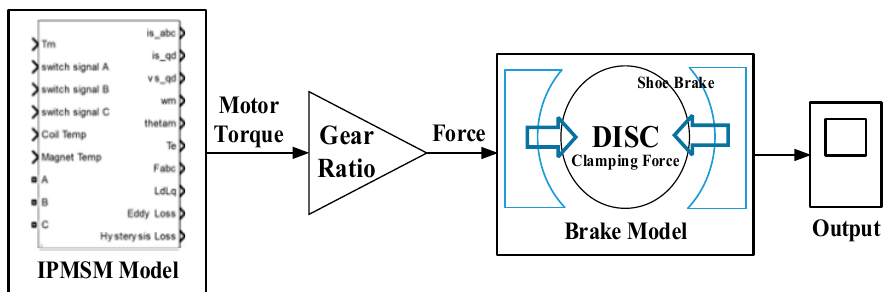
Figure 7. IPMSM and brake model for Matlab/Simulink.